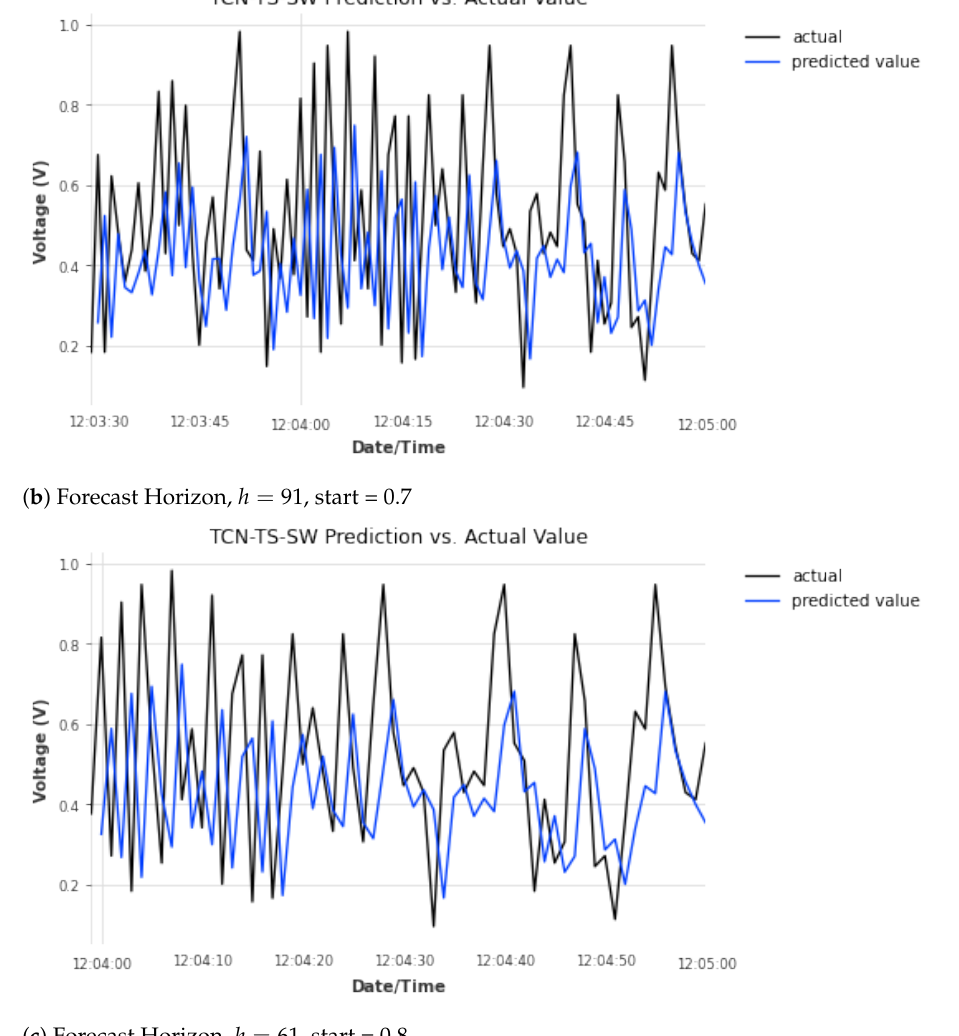
Figure 6. The plotted result between the actual and predicted values. The network has a ∆ = 300 with a training/validation ratio of 70/30. The x-axis represents the time of the execution, and the y-axis represents the voltage (Volts) that represents the raw readings from the temperature